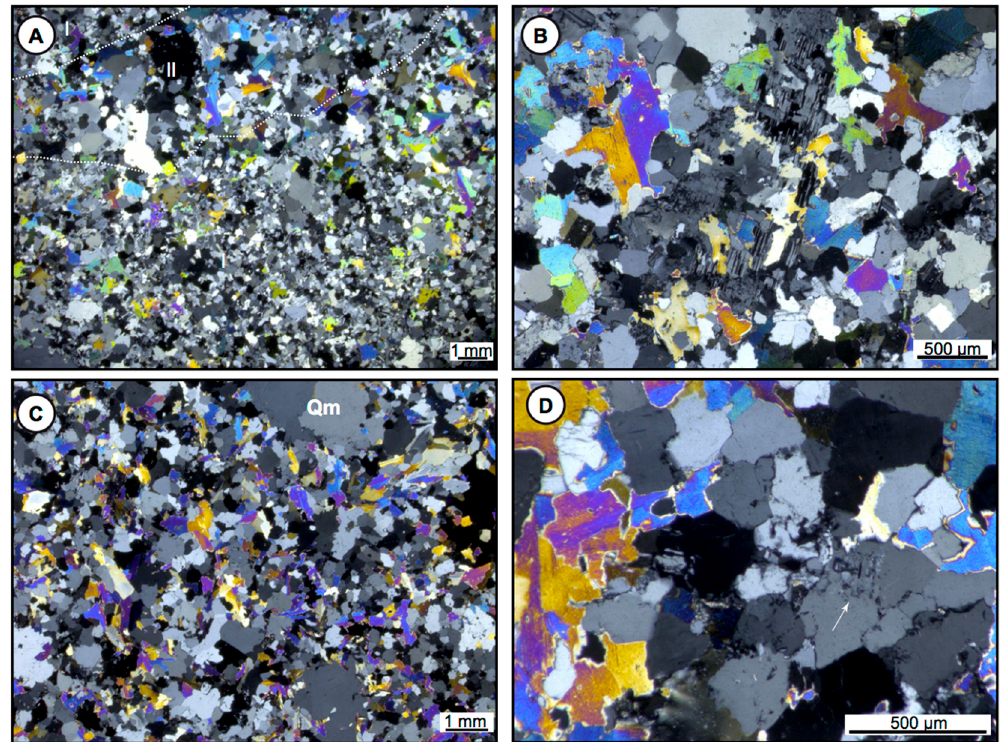
Figure 15. “Greisenisation” in the granites from the SCP2 drill-hole (microphotographs cross-polarized light, sample PAN16-4b). ( A ) Partially “greisenised” G1a granite. A strip of a quartz-muscovite assemblage (II) is superimposed on the equigranular albite granite (I). Note the abundance of muscovite in the granite. ( B ) Replacement of a G1a albite megacryst by amoeboid muscovite (sample PAN16-4b). ( C ) Overview of the fully greisenised G1b granite (sample PAN16-3a). Note the preservation of magmatic quartz (Qm). ( D ) Detail of the greisen, showing the relic lace-shaped albite within the quartz (arrow) (sample PAN16-3a).